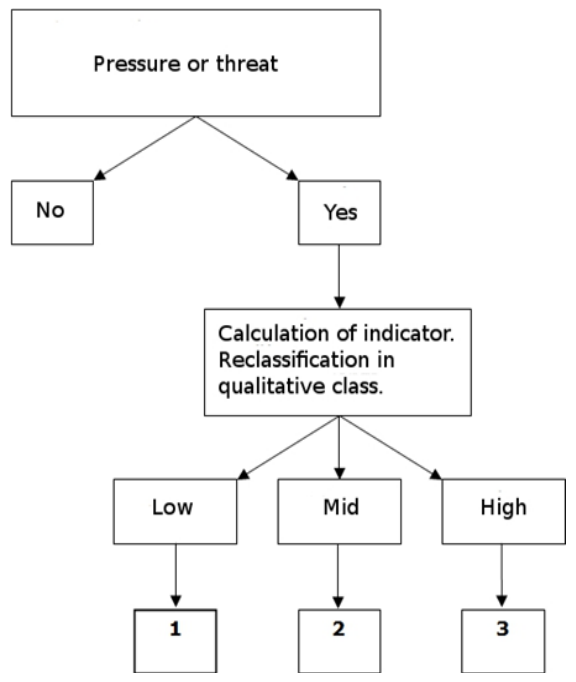
Figure 5. Assessment of the influence class.